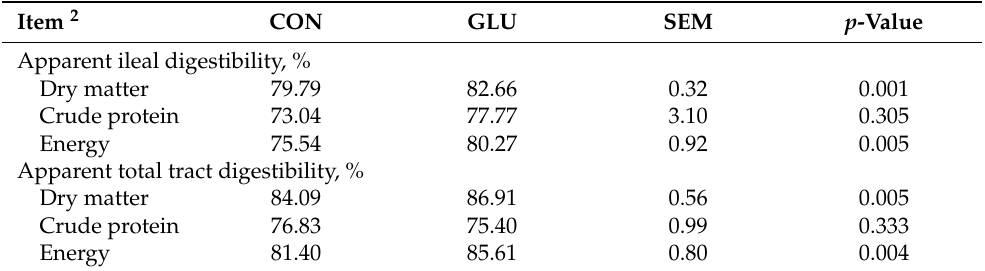
Table 4. Effects of dietary treatments on nutrient digestibility of weaned pigs 1 .